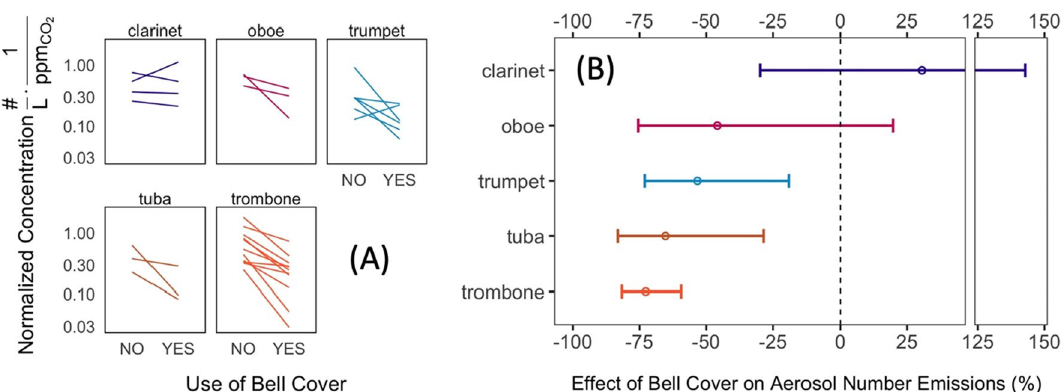
Figure 4. Effect of bell covers on reducing aerosol number emissions (0.25–35.15 μm size range) from instruments. ( A ) Participant-specific changes in CO 2 -normalized aerosol number concentration with bell covers (each line represents a pair of measurements for a participant with and without a bell cover). ( B ) Average percent reduction in emissions with 95% confidence intervals. Data are background corrected and restricted to instruments with n ≥ 3 measurement